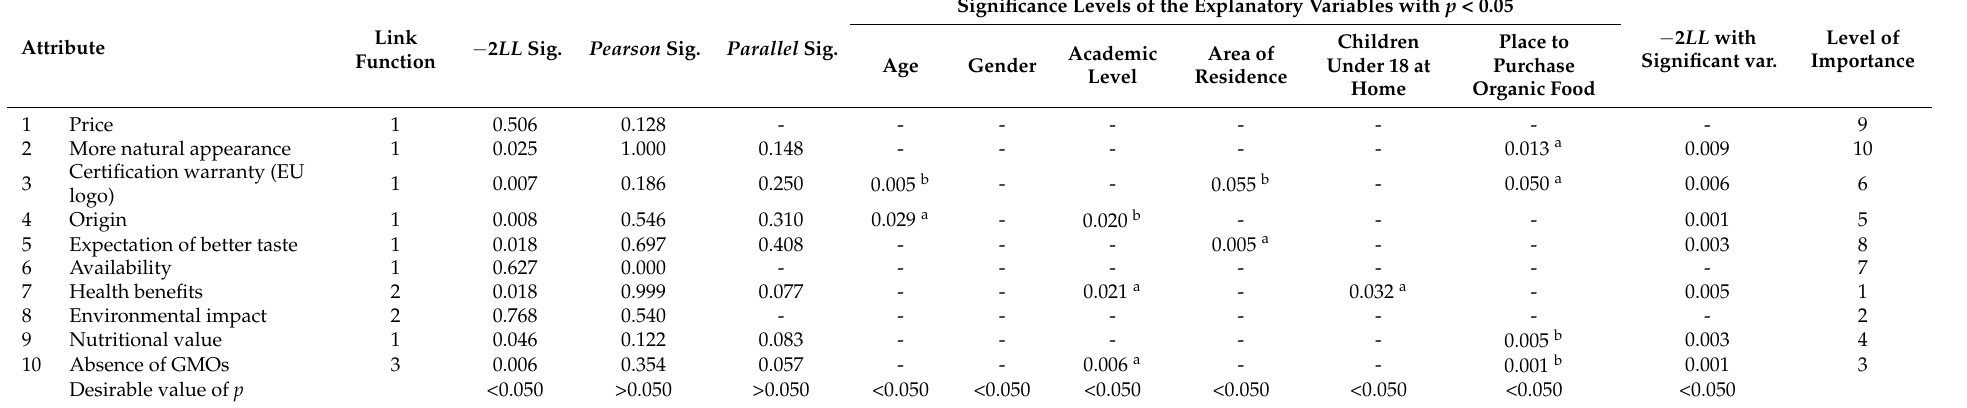
Table 5. Ordinal regression models of the attributes vs. classification